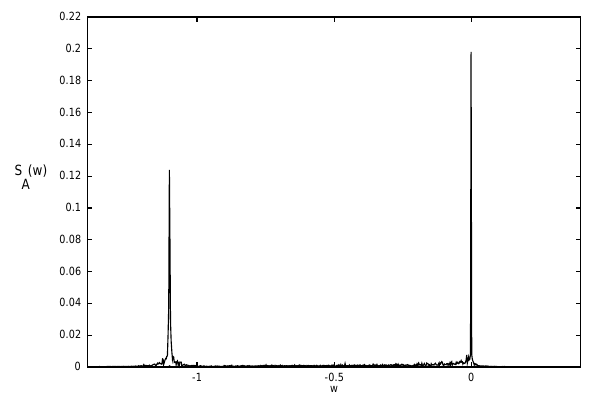
FIG. 5. Frequency spectrum of the centroid motion (over 2 17 turns, N (cid:1) 10 4 ) for the case of round beams colliding head- on with an initial offset of d (cid:1) 0.2 (in units of s x ). The ratio of the currents is equal to r (cid:1) 1 . The horizontal axis gives the tune shift from the unperturbed tune Q in units of j , i.e., w (cid:1) (cid:2) n 2 Q (cid:3)(cid:1) j . The vertical axis is the corresponding amplitude obtained from an FFT, on a linear scale. The p mode at w (cid:1) 2 1.1 is not damped and its amplitude is constant over this time.